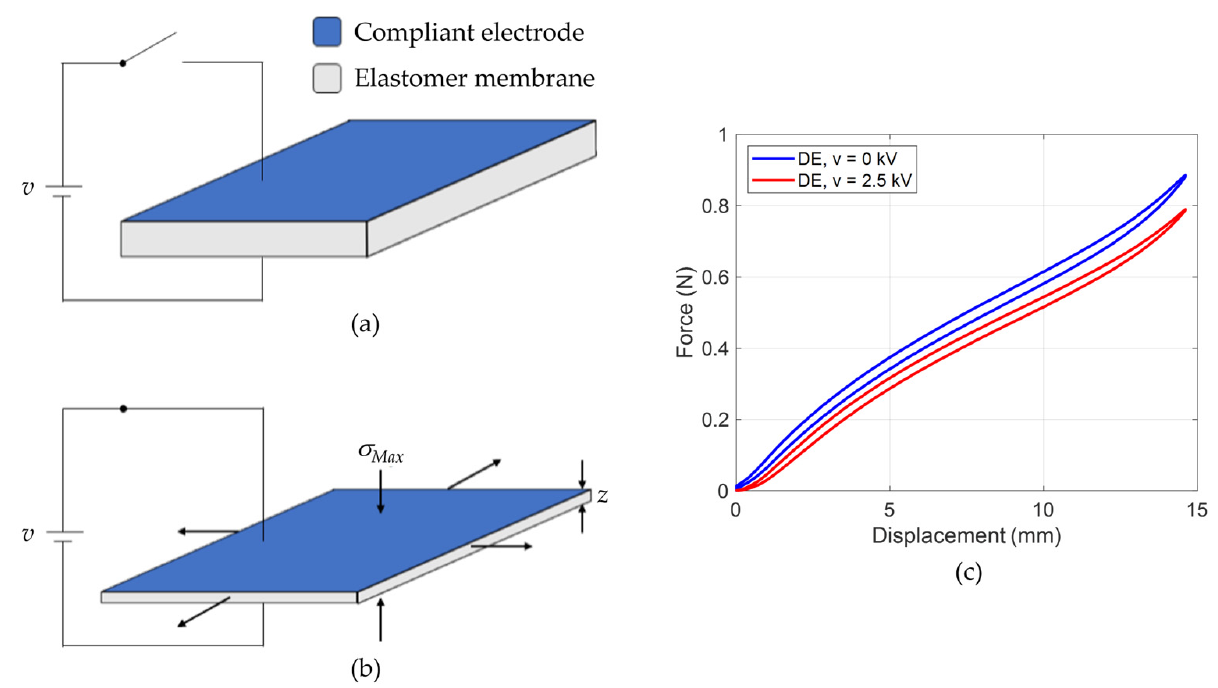
Figure 1. Operating principle of a DEA, deactivated state ( a ), activated state ( b ), and example of force-displacement characteristics for different applied voltages ( c ).